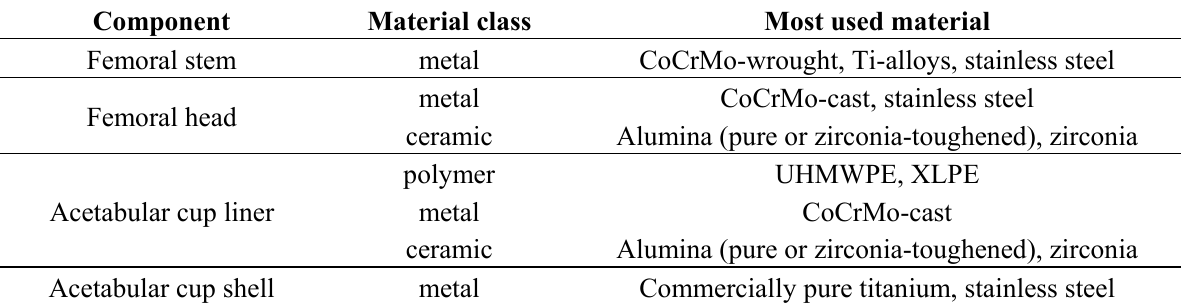
Table 1. Current most popular and deployed combination alternatives for total hip replacement surgery [37]. Titanium alloys mostly used are Ti between yttria-stabilized tetragonal zirconia polycrystal (TZP), Alumina (Al dispersion ceramics alumina-stabilized zirconia (ATZ) and zirconia-stabilized alumina (ZTA). For a more in depth discussion of these ceramics please refer to